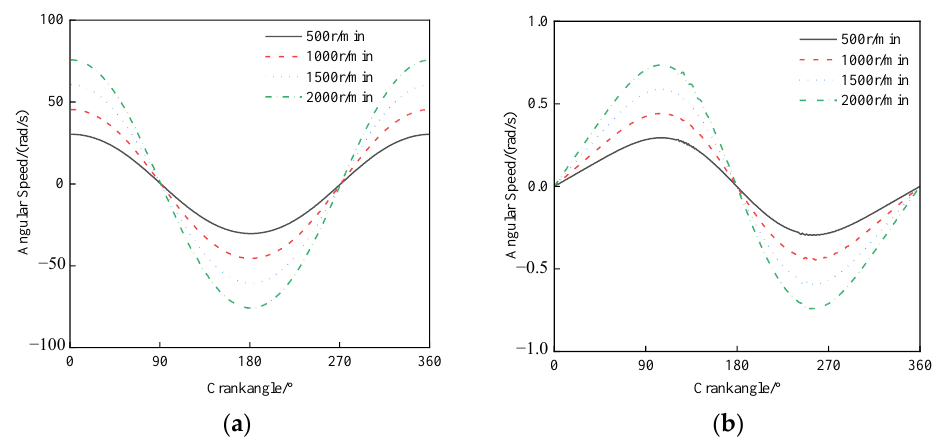
Figure 17. ( a ) Engine speed influences bushing rotation speed. ( b ) Engine speed influences piston pin rotation speed.